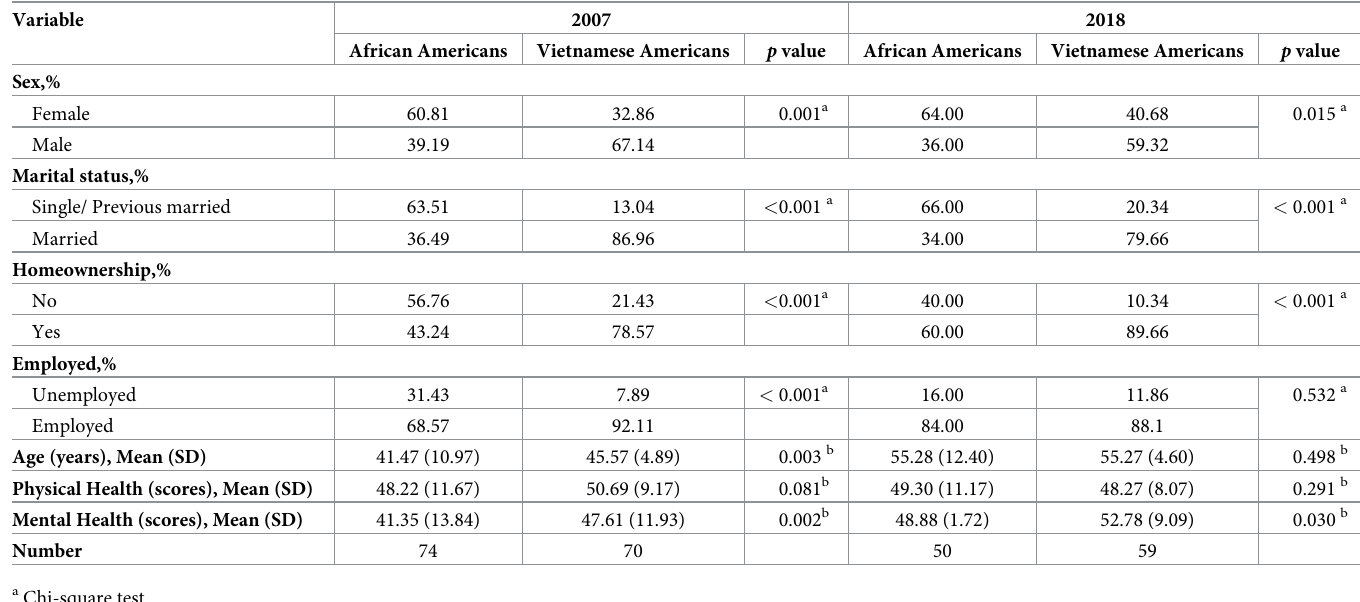
Table 1. Background characteristics of the African American and Vietnamese American participants in 2007 and 2018, applying bivariate analysis.